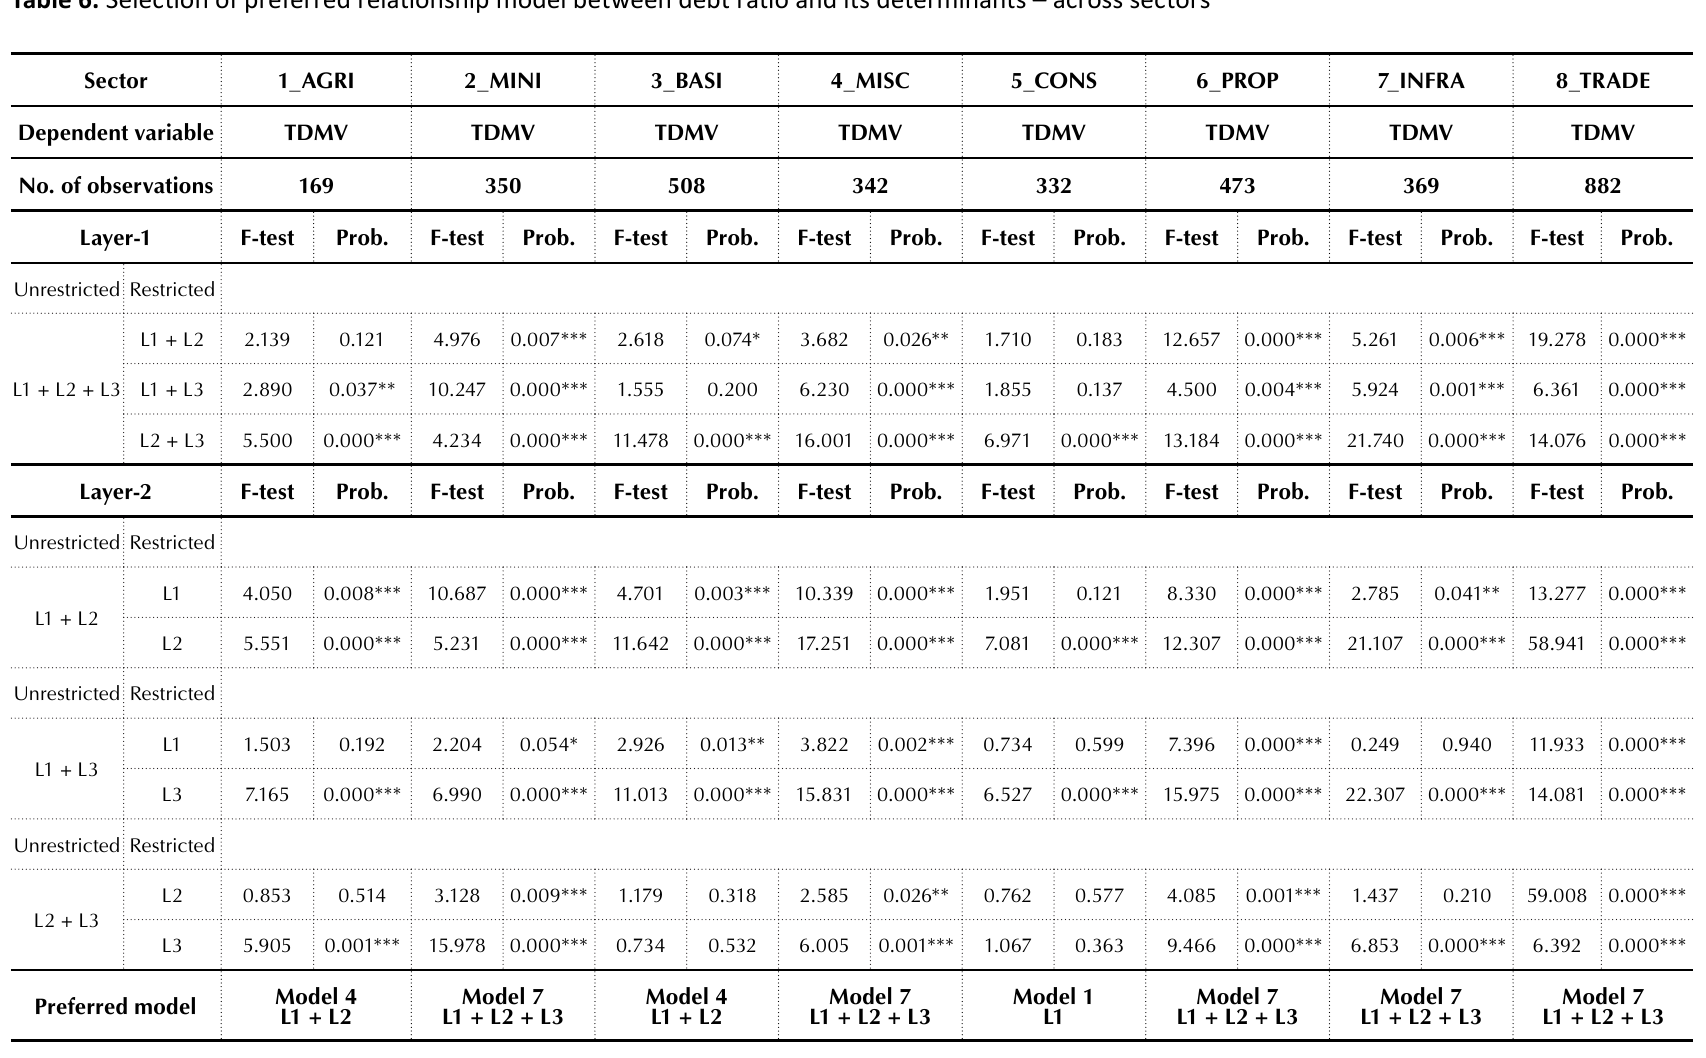
Table 6. Selection of preferred relationship model between debt ratio and its determinants – across